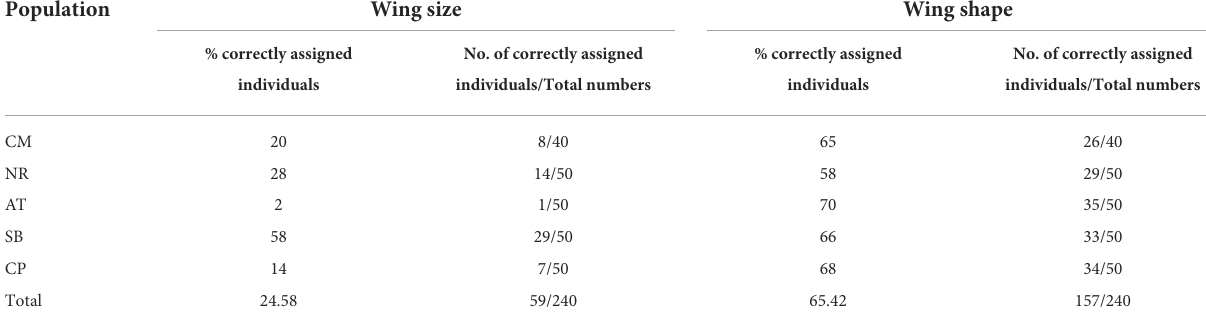
TABLE 5 Scores of validated classification based on the maximum likelihood for wing size and Mahalanobis distance for wing shape among Tabanus rubidus populations. Population Wing